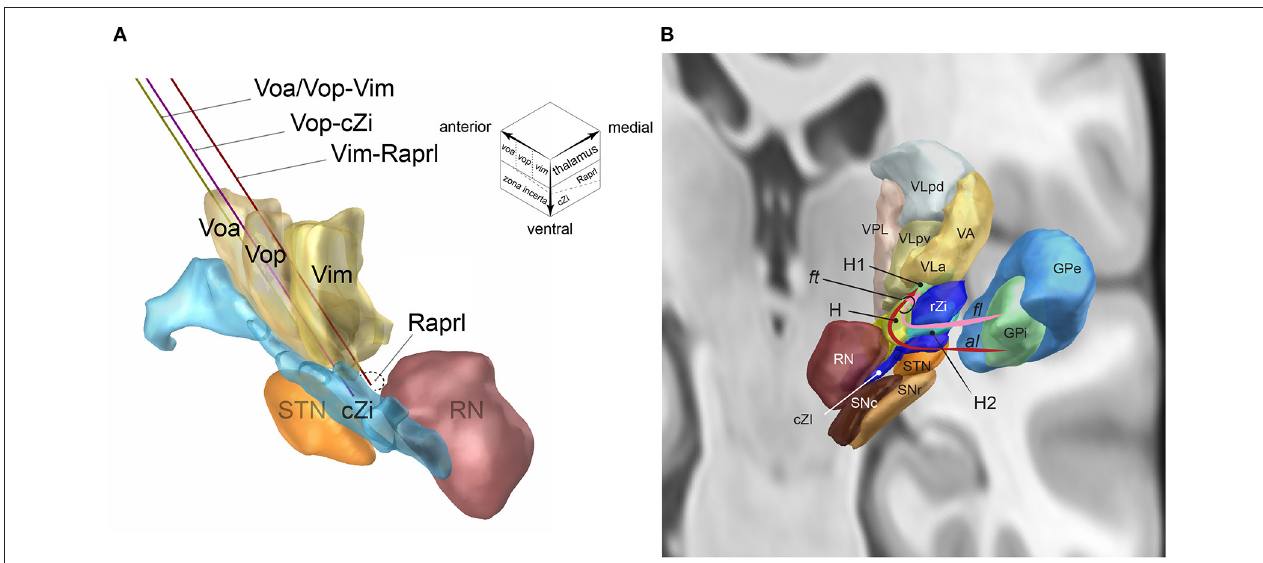
FIGURE 1 | (A) The single DBS-lead dual-target trajectories going through two-story targets made of the ventral thalamic nuclei (upstairs) and posterior subthalamic area (downstairs, inset): Voa/Vop-Vim (yellow), Vop-cZi (blue), and Vop-Raprl (brown). Voa, nucleus ventralis oralis anterior; Vop, nucleus ventralis oralis posterior; Vim, nucleus ventralis intermedius; cZi, caudal zona incerta; Raprl, prelemniscal radiation; RN, nucleus ruber; STN, nucleus subthalamicus. The upper right voxel scheme illustrates the two-story structure of ventral motor nuclei of the thalamus (upstairs) and subthalamus (downstairs). (B) Fasciculus lenticularis ( fl ) leaves from dorsal globus pallidus interna (GPi), enters the field H2 of Forel (H2) between rostral zona incerta (rZi) and the subthalamic nucleus (STN), joined with ansa lenticularis( al ) from ventral GPi in the field H of Forel (H), rostral to the red nucleus (RN), and form the fasciculus thalamicus ( ft ) in the field H1 of Forel (H) then projects to the VA, and VLa nuclei of the thalamus. GPe, GP externa; SNc substantia nigra pars compacta; SNr, SN pars reticulata; VLpd and VLpv, ventrolateral posterior dorsal and ventral nuclei of the thalamus; VPL, ventroposterolateral nucleus of the thalamus [Reproduced from Toda et al. (2021) with permission from the Igaku-Shoin, Ltd., Japan]. The figure components are generated using Lead-DBS